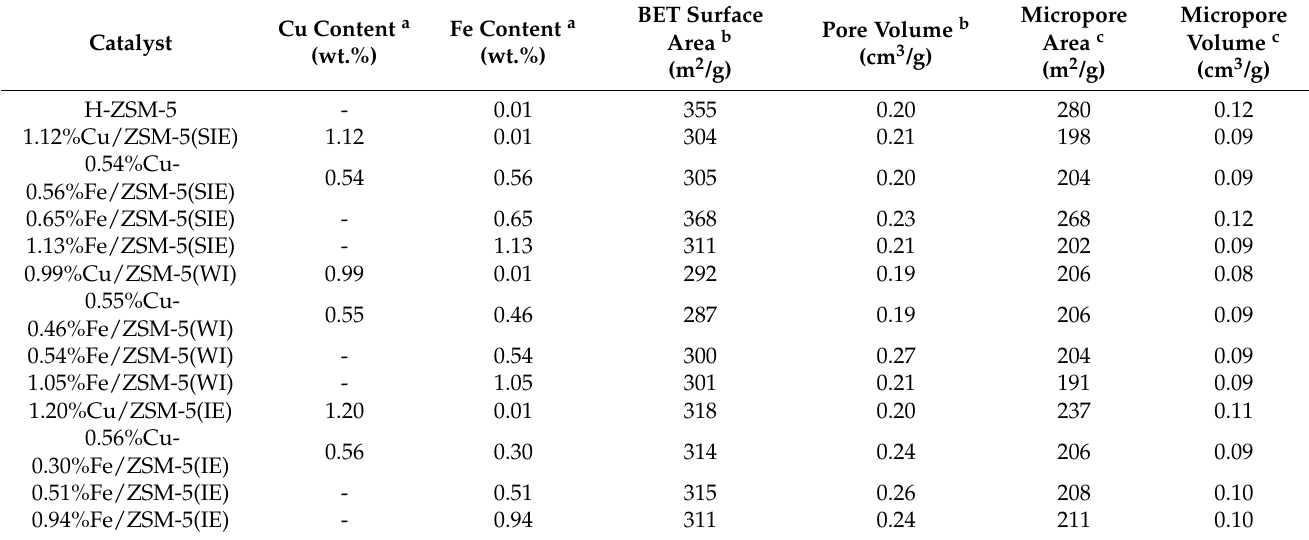
Table 1. The textural properties of the prepared catalysts.